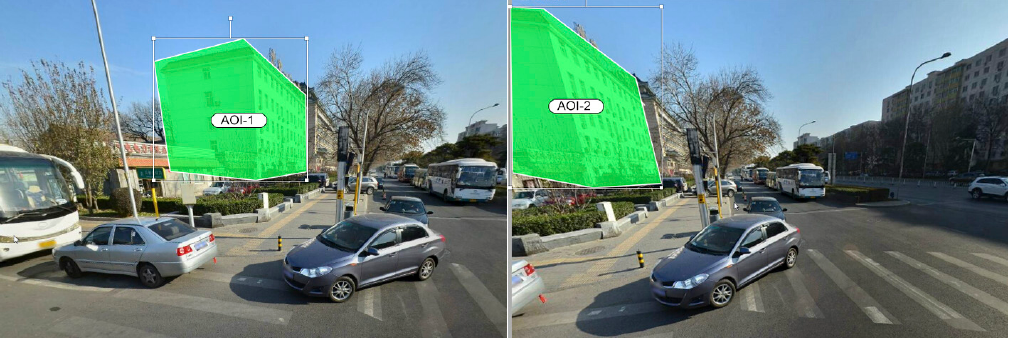
Figure 5. Illustration of generating dynamic AOIs of LM2 at Crossroad 1 for quantitative fixation analysis. The pictures were from Baidu Map (http://ditu.baidu.com) under free license for non-commercial use.